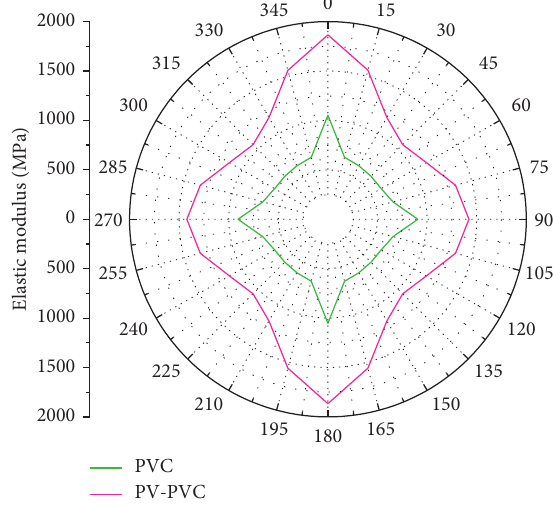
Figure 17: Elastic modulus of PV-PVC composite and PVC